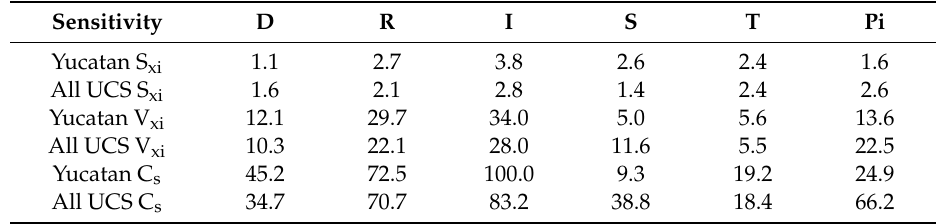
Table 4. Parameters sensitivity of the KARSTIC method without the A and C